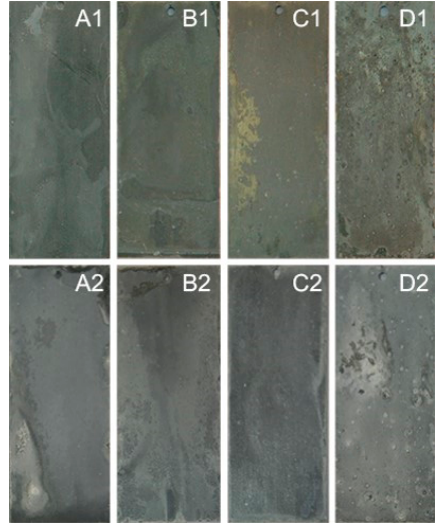
Figure 6. The morphology of immersion specimen, A1, B1, C1, D1, A2, B2, C2, and D2 are the 23AZS, 23AZS–1.5Mg, 23AZS–3Mg, and 55AZS after immersing for four and 59 days, respectively.